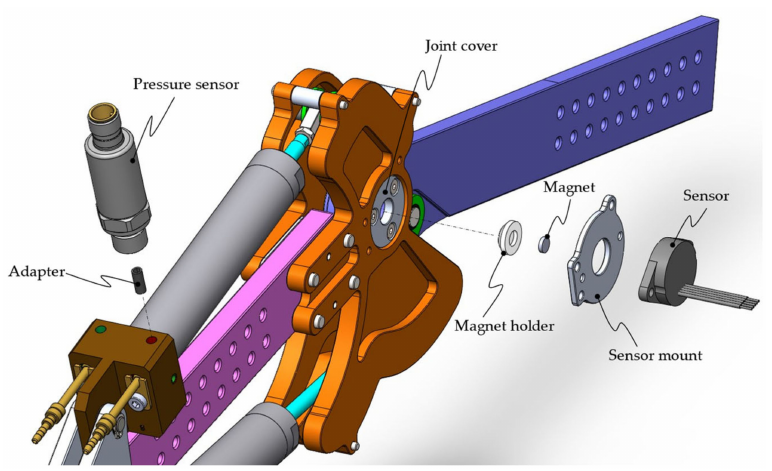
Figure 24. Sensor integration into the exoskeleton